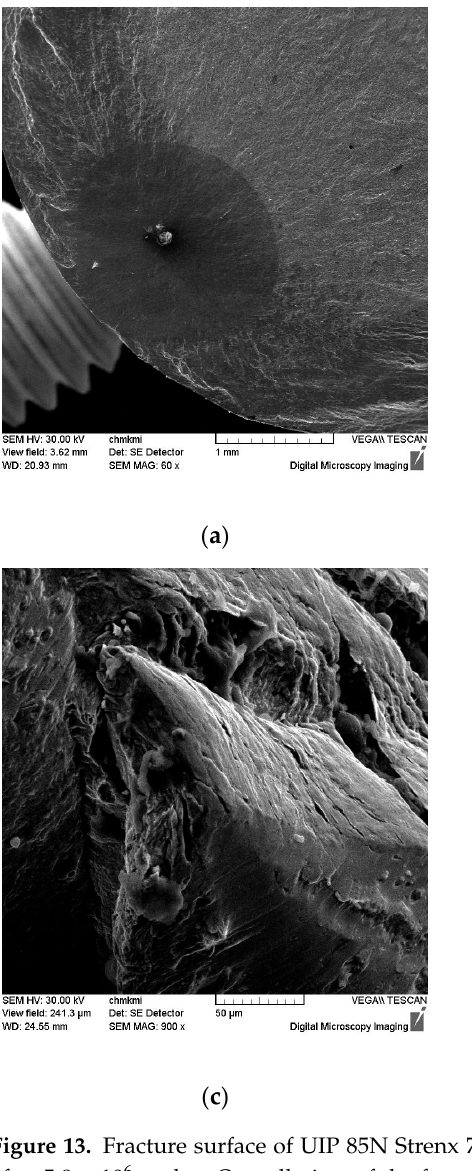
Figure 12. Fracture surface of as-welded Strenx 700 MC specimen loaded at 395 MPa and fractured after 6.86 × 10 5 cycles: Overall view of the fracture ( a ), detail of surface fatigue crack initiation ( b ), fatigue crack propagation with intercrystalline facet ( c ) and final fracture ( d ).